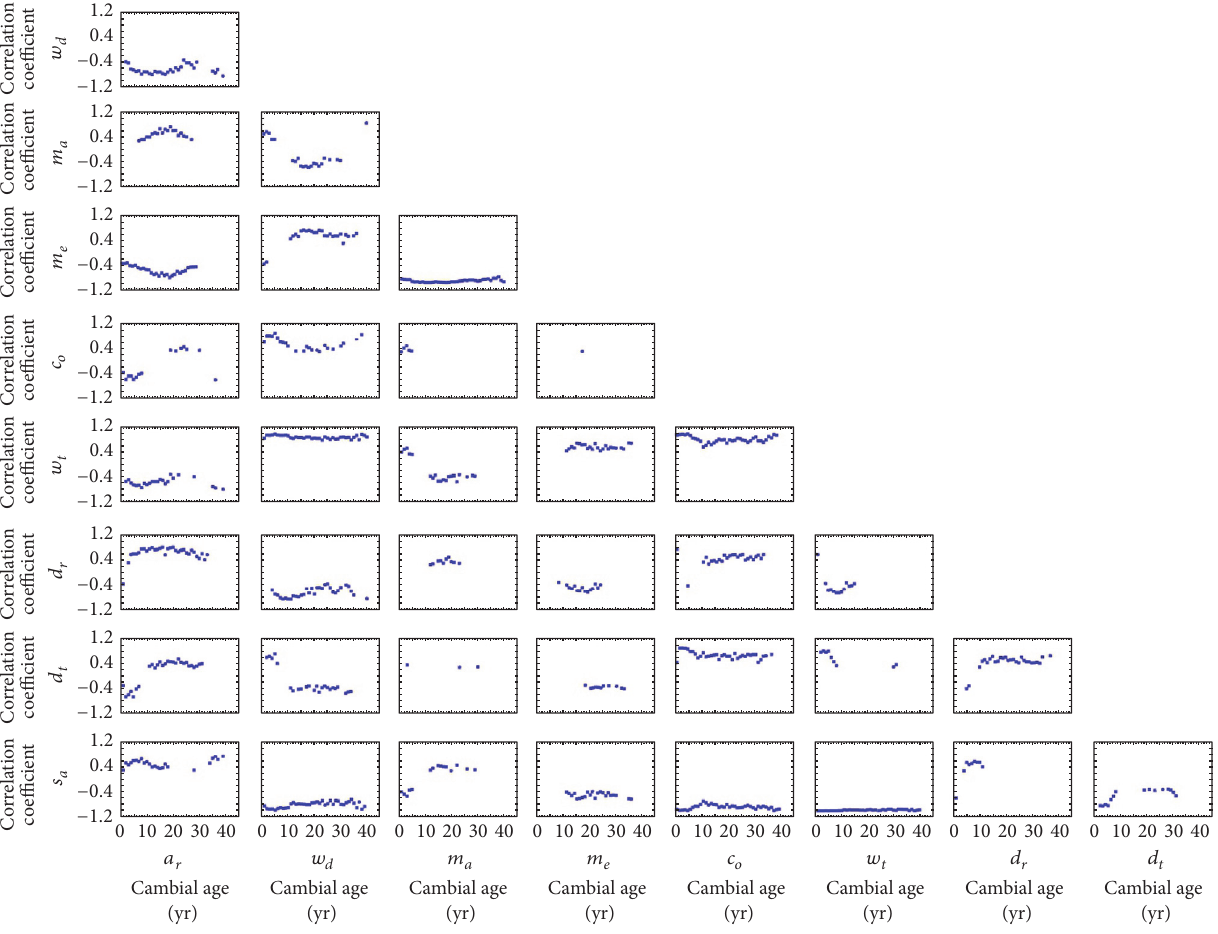
Figure 1: Matrix of temporal annual correlation patterns for bivariate relationships between individual attributes by cambial age. Note: ( 1 ) only Pearson moment correlation coefficients which were significant ( 𝑝 ≤ 0.05 ) are displayed, and ( 2 ) 𝑎 𝑟 , 𝑤 𝑑 , 𝑚 𝑎 , 𝑚 𝑒 , 𝑐 𝑜 , 𝑤 𝑡 , 𝑑 𝑟 , 𝑑 𝑡 , and 𝑠 𝑎 denote annual-ring-width area, wood density, microfibril angle, modulus of elasticity, fibre coarseness, tracheid wall thickness, radial tracheid diameter, tangential tracheid diameter, and specific surface area,